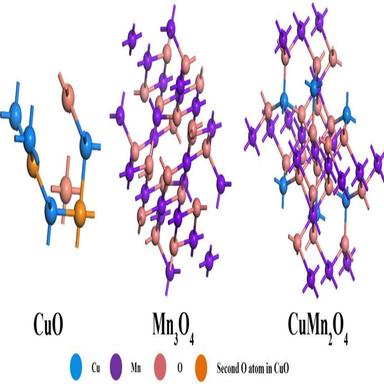
View of the CuO, Mn3O4, and CuMn2O4 unit cell structures. (the two types of O sites in CuO structure were separately marked in light-red and light-orange due to the AFM magnetic structure distribution. The light-red O atoms were finally selected as the O vacancy site. The purple and blue spheres represent Mn and Cu atoms, respectively.)